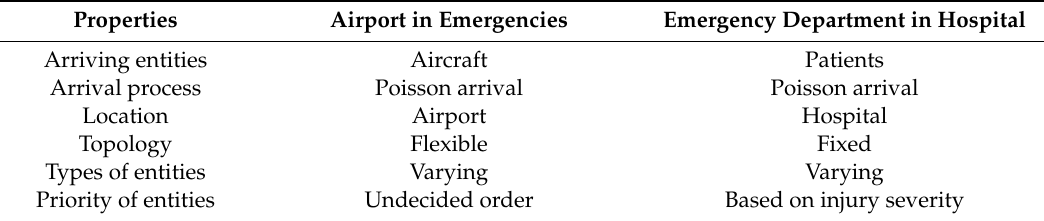
Table 1. Features of airports in emergencies / emergency